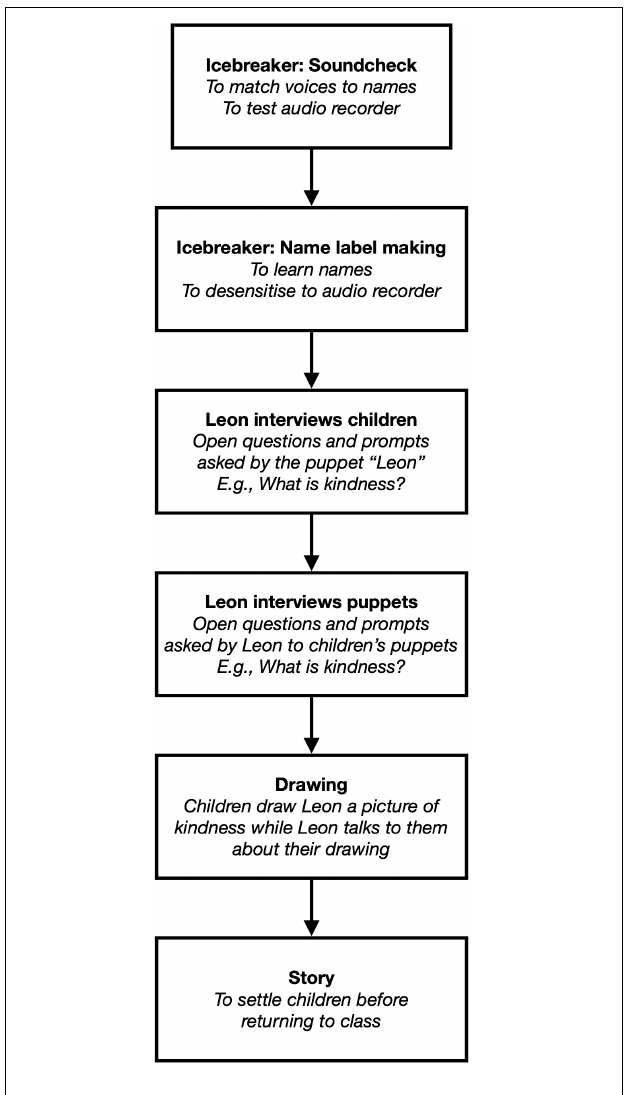
FIGURE 1 | Interview